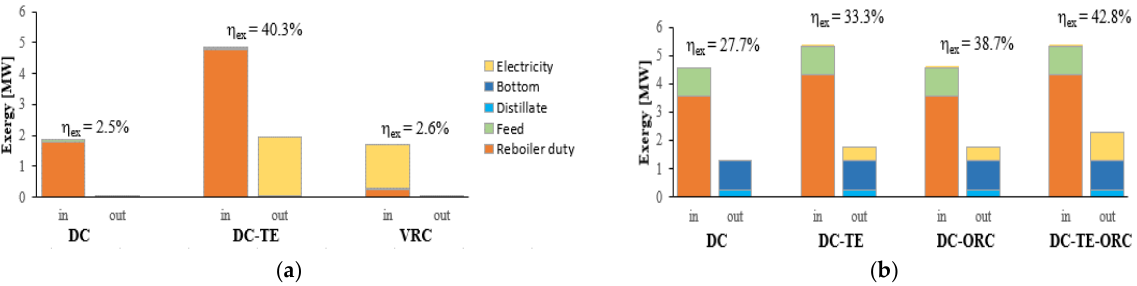
Figure 7. Energy efficiency of different integrated columns for ( a ) iso-pentane/n-pentane and ( b ) naphtha distillation.